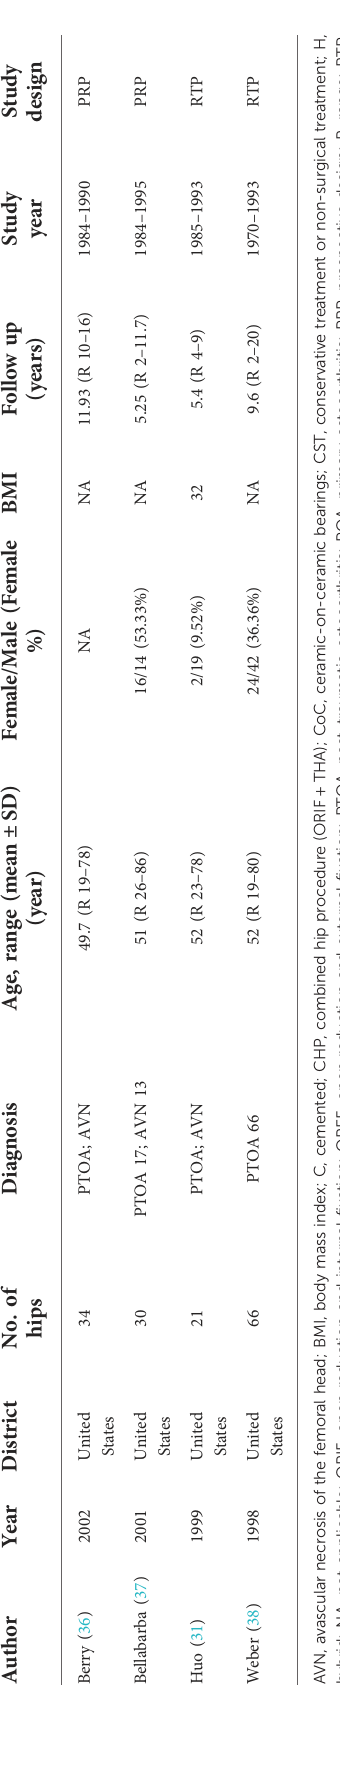
( Supplementary Figure S2 ). For OHS, four studies (13, 14, 26, 27) with an MD of 25.22 were pooled, indicating a large effect (19.99 – 30.46; Figure S3 ). Signi fi cant heterogeneity was found among these four studies ( I 2 = 94.3%, P < 0.001). For MDA, two studies (11, 27) were indicated a large effect ( Supplementary Figure S4 ).